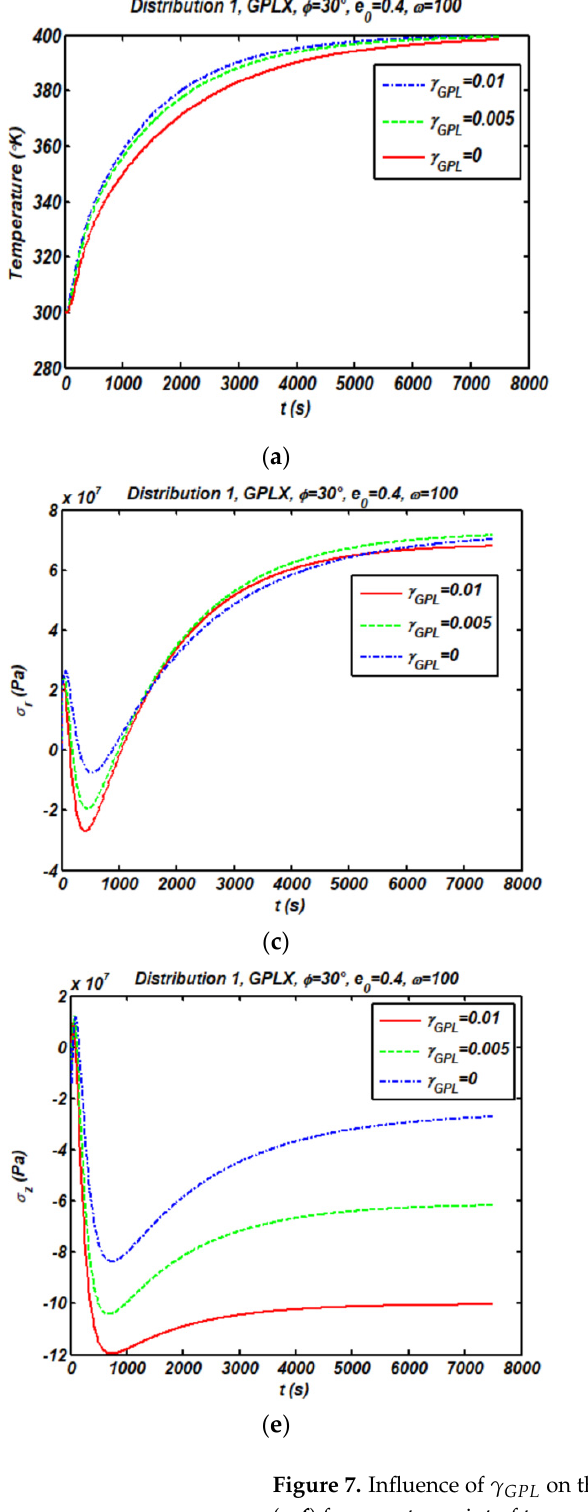
ω φ = 30°; = 100 rad/s).